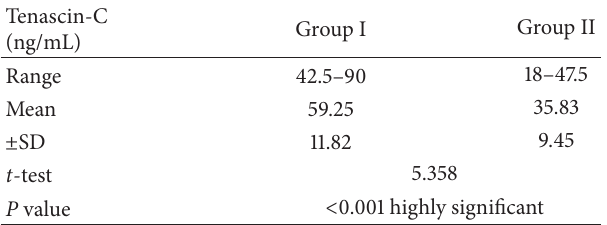
Table 2: Serum tenascin-C levels in groups I and